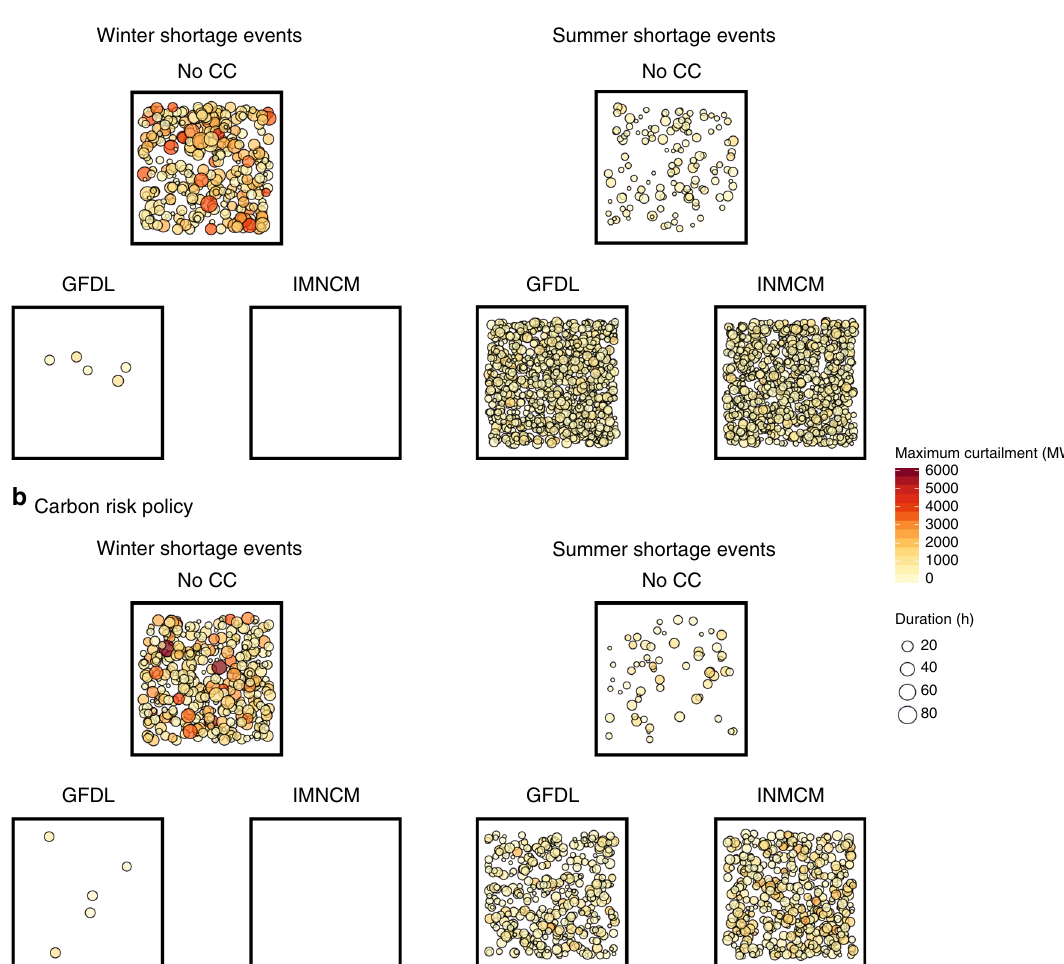
Fig. 3 Power shortfall events in 2035. Each point represents a simulated shortfall event within either winter or summer from 6000 one-year simulations. Number of points indicates frequency of occurrence, whilst size and color give duration and maximum curtailment, respectively. Points are positioned randomly inside each